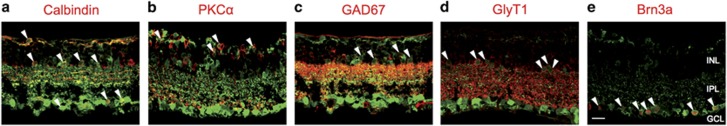
Confocal fluorescence micrographs of degenerate mouse retinas injected with three serotypes of AAV-GFP and double labelled for GFP and retinal cell markers. Degenerate rd1 mouse retinas were injected either intravitreally or subretinally with an AAV vector expressing GFP driven by a ubiquitous promoter, with one of three AAV serotypes: AAV2/8(Y733F), AAV2/2(quad Y-F) or AAV2/2(7m8). Vertical sections were double immunolabelled for GFP and retinal cell markers: (a) calbindin; (b) protein kinase-Cα (PKCα); (c) glutamate decarboxylase 67 (GAD67); (d) glycine transporter 1 (GlyT1) or (e) brain-specific homeobox/POU domain protein 3a (Brn3a). Cell bodies that were immunopositive for both GFP and the cell marker are encircled. Arrowheads indicate GFP-expressing retinal pigment epithelium (RPE). The RPE cannot be identified in the majority of the panels because of it detaching during sample preparation. See Table 1 for a summary of the colocalisation results. GCL, ganglion cell layer; INL, inner nuclear layer. Scale bar, 20 μm.